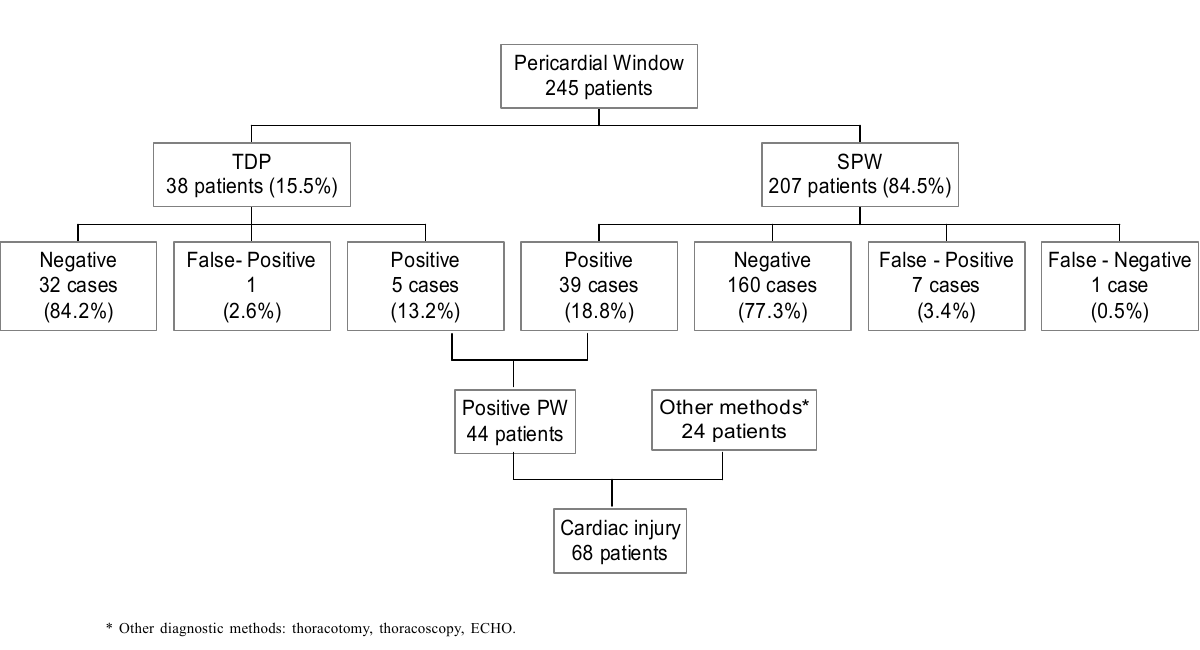
FIGURE 2 - Algorithm representing the results for patients in this study.